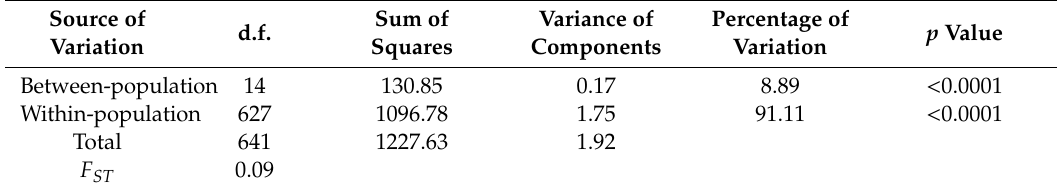
Table 3. Hierarchical molecular variance (AMOVA) of the MT-CYB in 15 indigenous Tibetan sheep populations. Sum of Variance of d.f. Squares